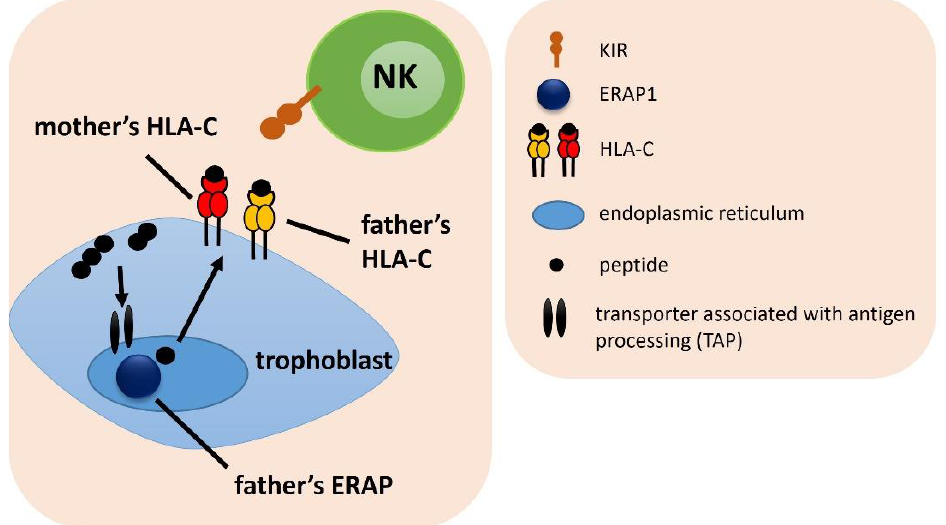
Figure 7 . The influence of male ERAP/HLA-C and female HLA-C on embryo implantation. The arrows indicate the successive stages of the formation of antigenic peptides.